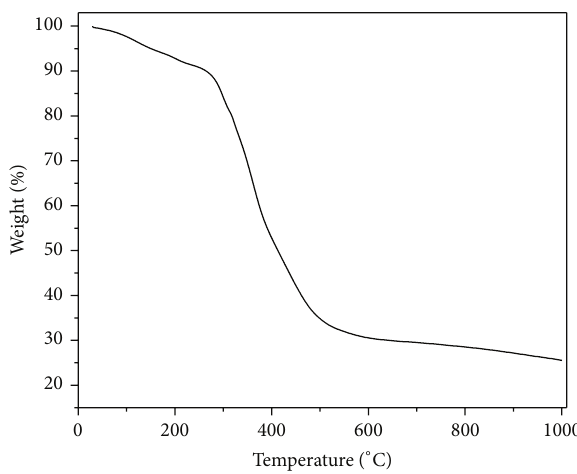
Figure 1: Thermogravimetric curve for emeraldine